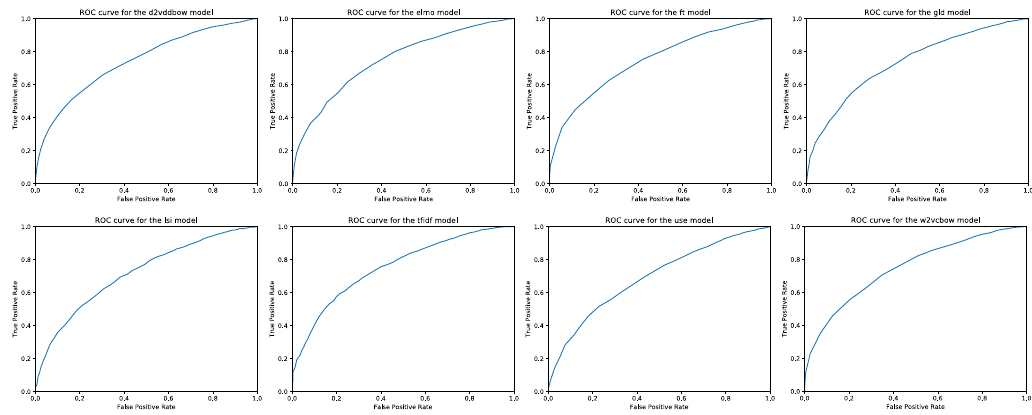
Figure A3. Precision/recall curves for eight models processing MSRP corpus.